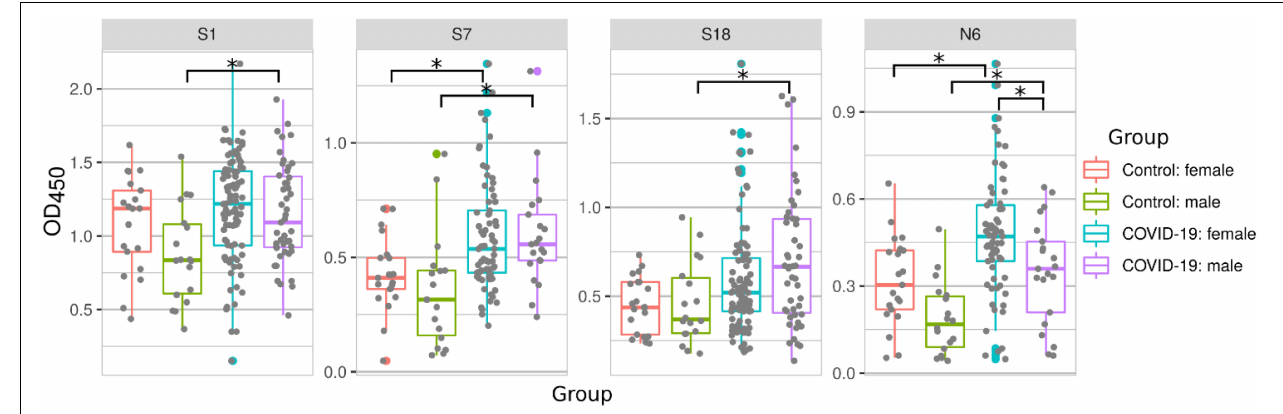
FIGURE 4 | COVID-19 serum reactivity with SARS-CoV-2 peptides depending on sex of patient. Antibody reactivity was analyzed using ELISA. Peptides were adsorbed on a 384-well plate and probed with serum samples. Asterisks indicate statistically significant differences between reactivity to SARS-CoV-2 peptides depending on sex of the patient ( p < 0.05, Kruskal-Wallis test with Benjamini-Hochberg adjustment).